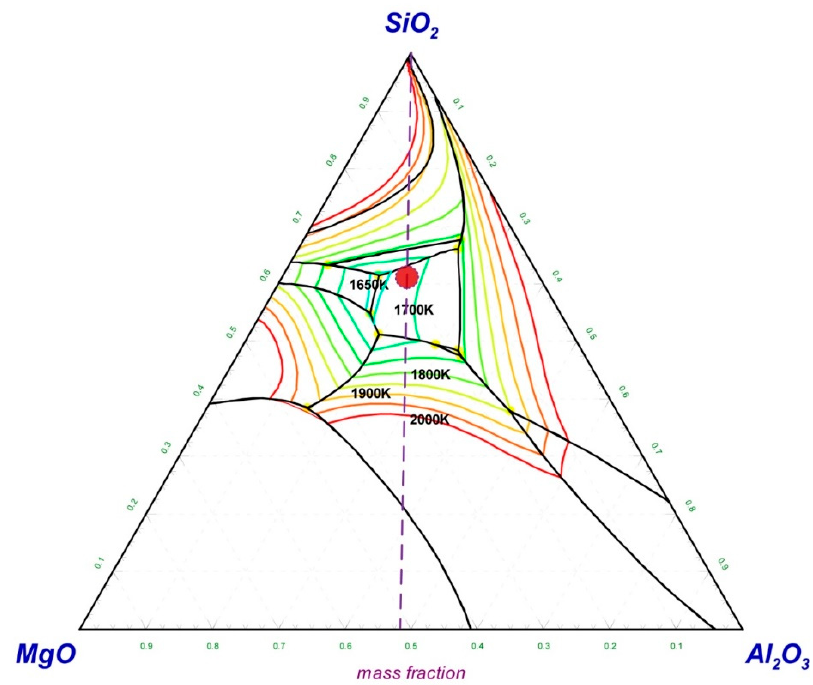
Figure 1. MgO–SiO 2 –Al 2 O 3 phase diagram with isotherm lines for p = 1 atm, drawn with FactSage 7.2.